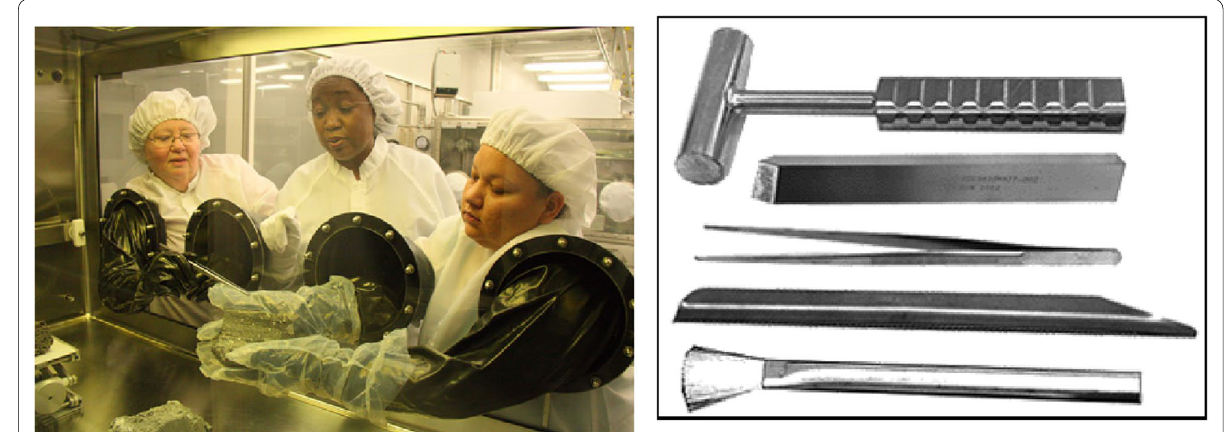
Fig.1 Glove box Cabinet (left) and typical tools (right) to process lunar samples made of special materials that are allowed to touch samples (Lunar Sample Laboratory Tour,